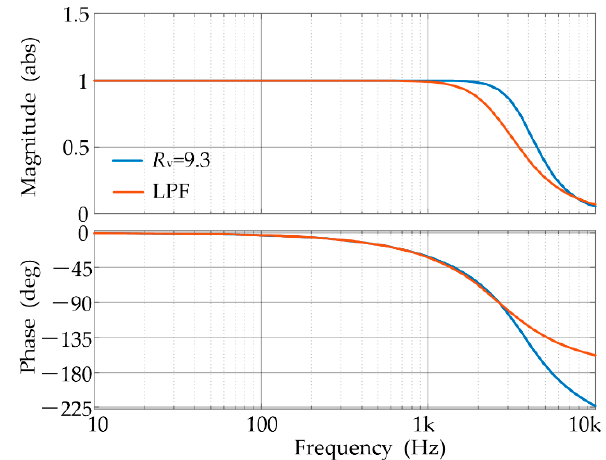
Figure 5. Comparison between the inverter and LPF.